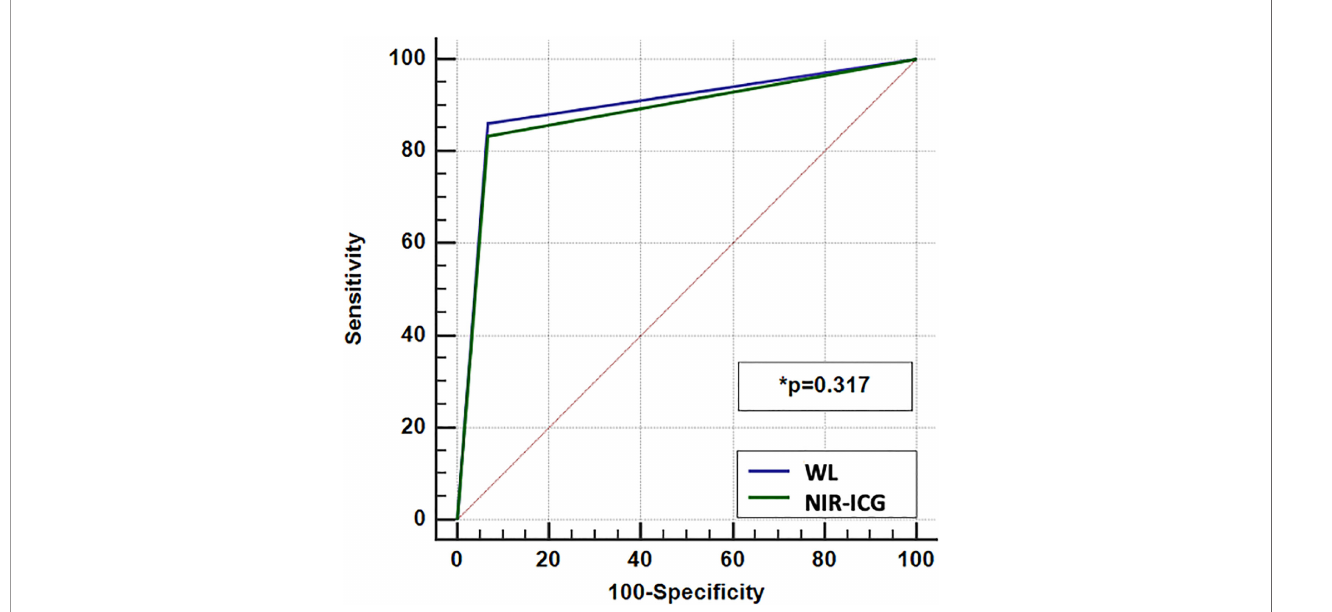
FIGURE 4 | ROC curves of the two approaches (white light and near-infrared indocyanine